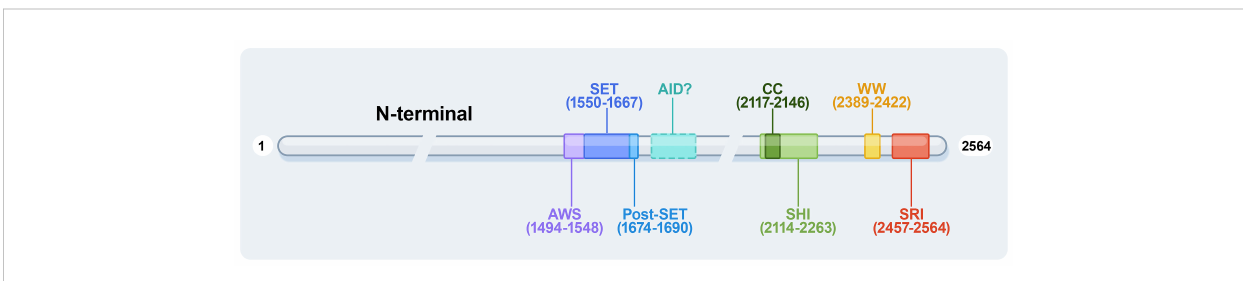
FIGURE 1 The protein domains of human SETD2. AWS, associated with-SET domain; AID, auto-inhibitory domain; WW, tryptophan-tryptophan domain; CC, coiled-coil domain; SHI, SETD2-hnRNP interaction domain; SRI, Set2-Rpb1 interacting